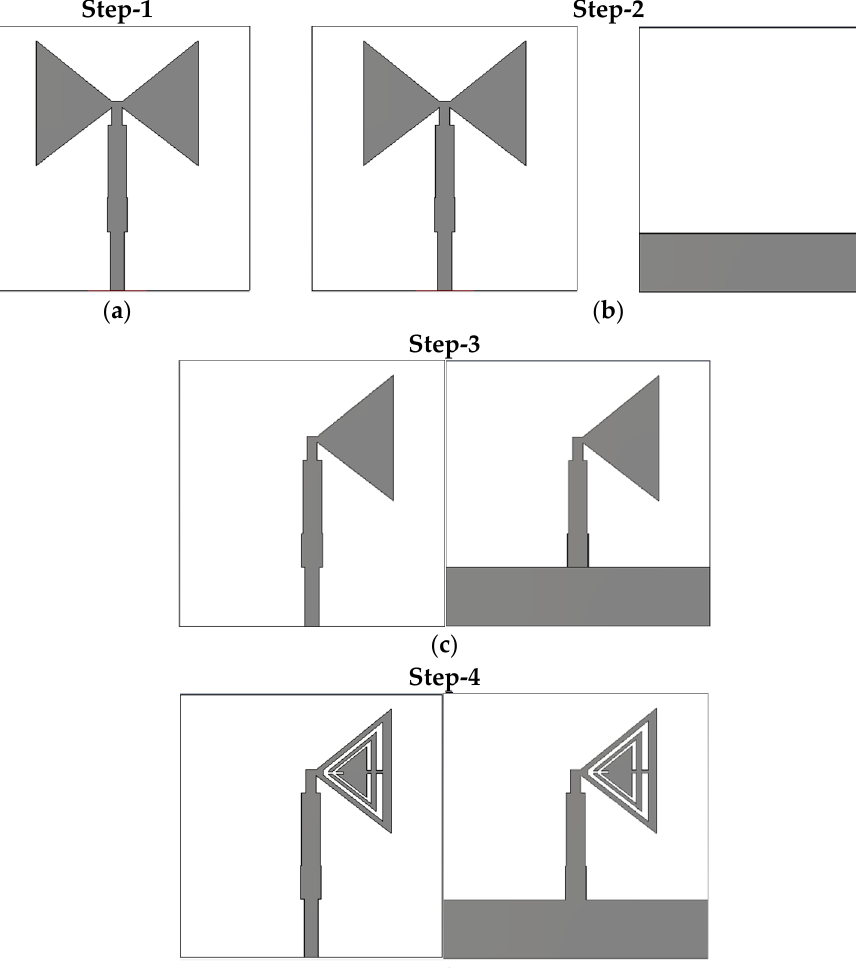
Figure 3. ( a ) Primary antenna with the complete ground plane. ( b ) Antenna with the partial ground plane. ( c ) Double-sided bowtie antenna with partial ground plane. ( d ) Double-sided bowtie antenna etched using a TCSRR structure with a partial ground plane.